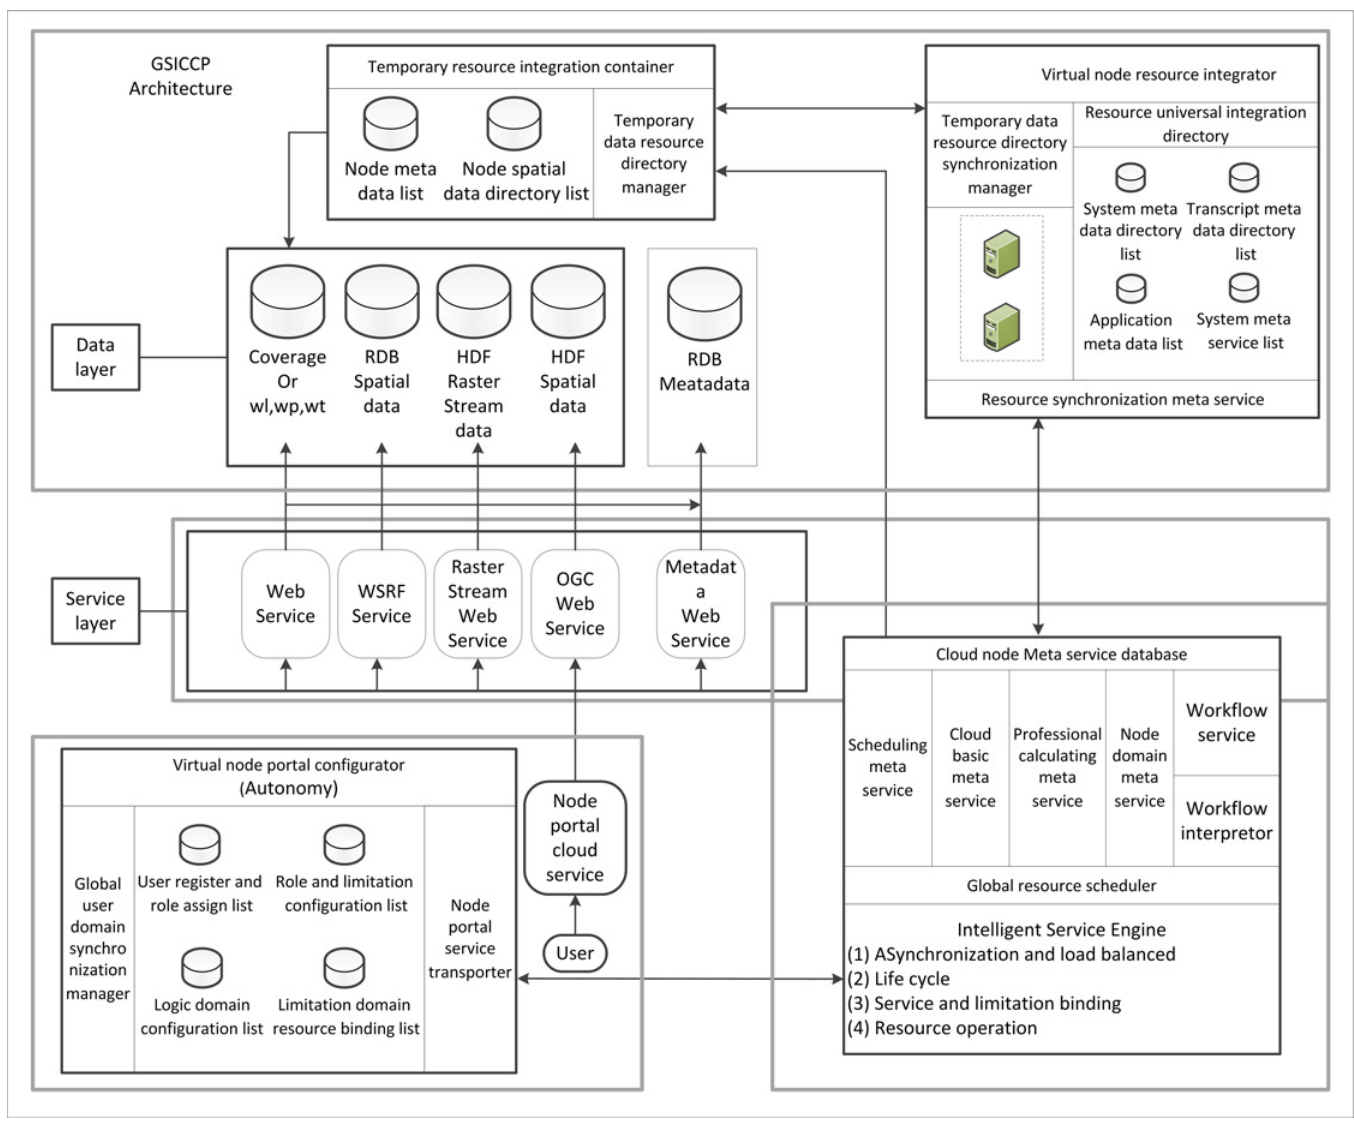
Fig 8. Architecture of the P2P node